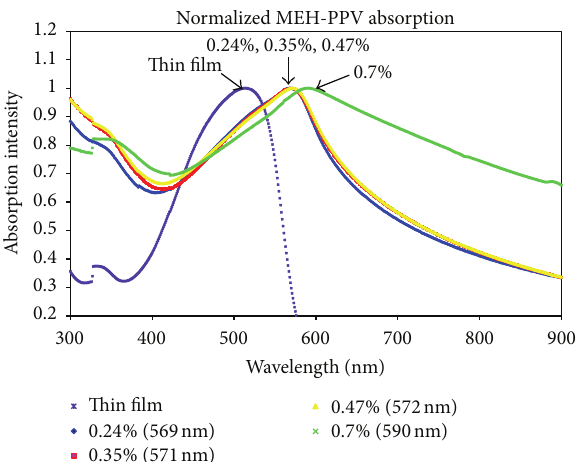
Figure 5: Photoluminescence of MEH-PPV nanofibers made from varying concentrations of MEH-PPV solutions. Excitation wave- length was 365nm.